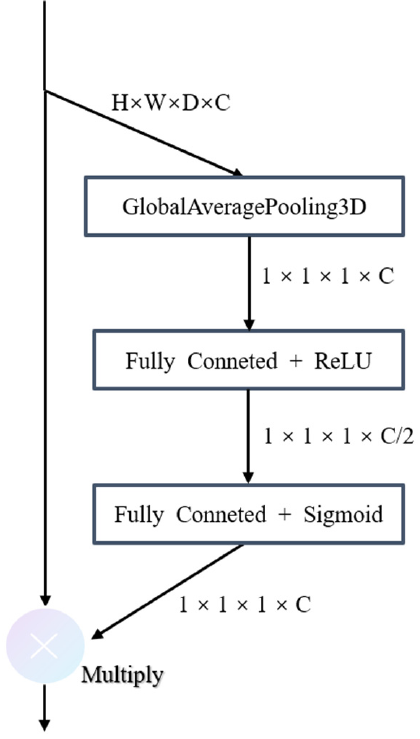
Figure 6. The structure of Senet. Unlike the regular 2D Senet, 3D average pooling is used to aggregate feature maps because the feature maps and input data in the network are three-dimensional.